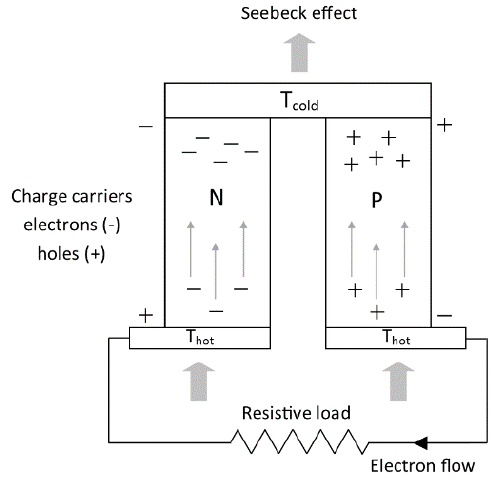
Figure 1. The principle of thermoelectric generation.